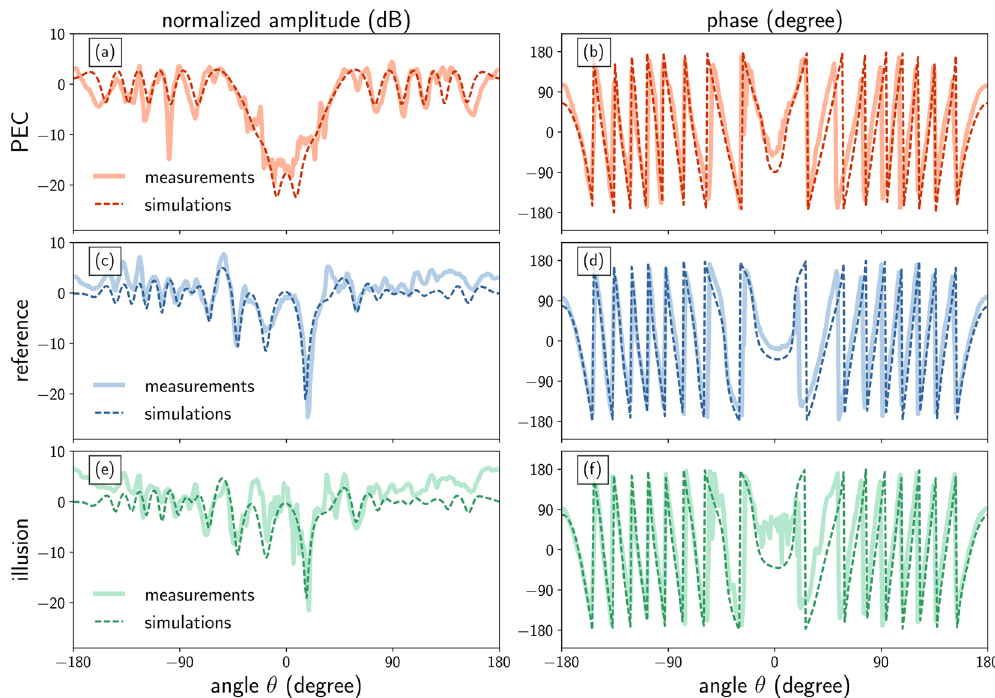
Figure 3. Amplitude and phase. Electric field magnitude normalized to the free space value (in dB, left column) and phase (in degree, right column) for the PEC cylinder ( a , b ), the reference dielectric object ( c , d ) and the illusion device ( e , f ). The measured (thick solid lines) and computed (thin dashed lines) values are plotted as a function of the observation angle θ (in degree) for a fixed radius r = 1.5 R ill